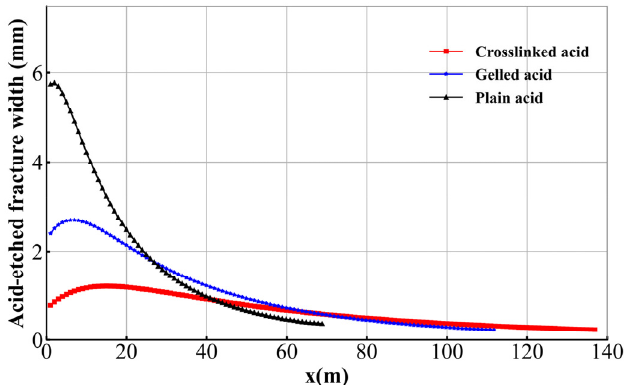
Figure 7. Acid-etched fracture width distribution of different acid solutions when considering the variation in mass transfer coefficient with temperature.